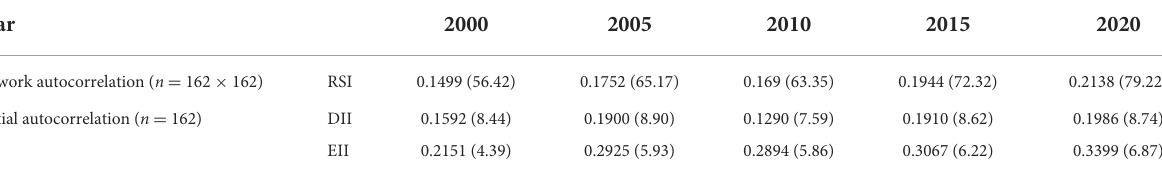
TABLE 4 The levels of spatial autocorrelation and network autocorrelation in spatial interaction index values.